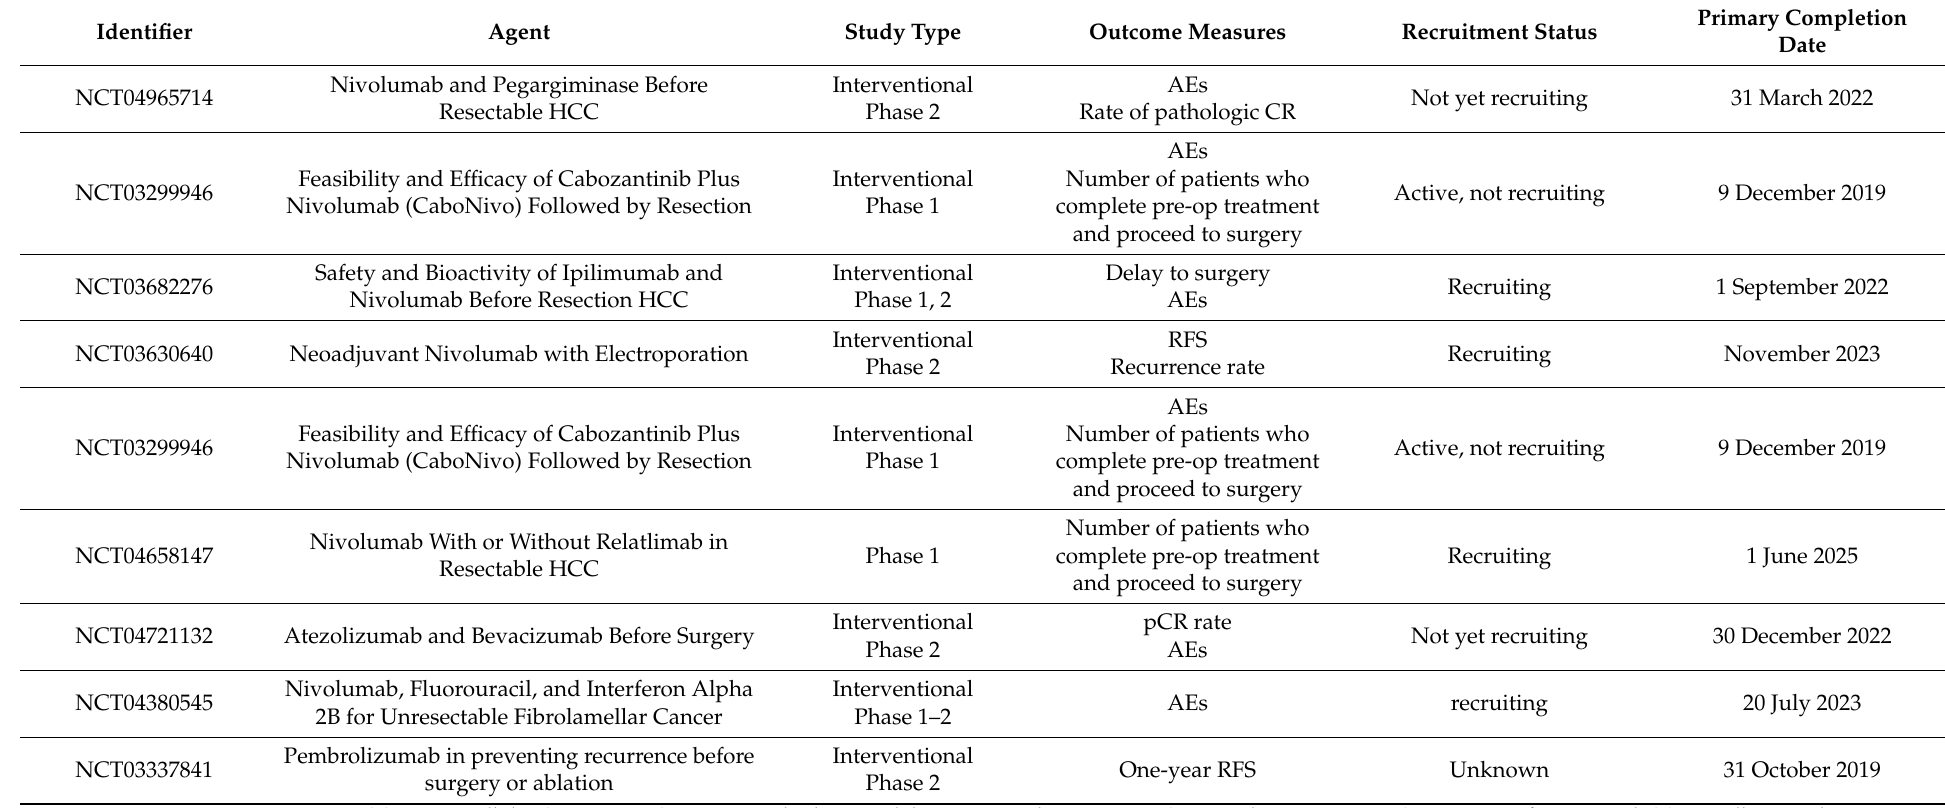
Table 1. Ongoing studies of neoadjuvant therapies investigating the combination of ICIs and curative